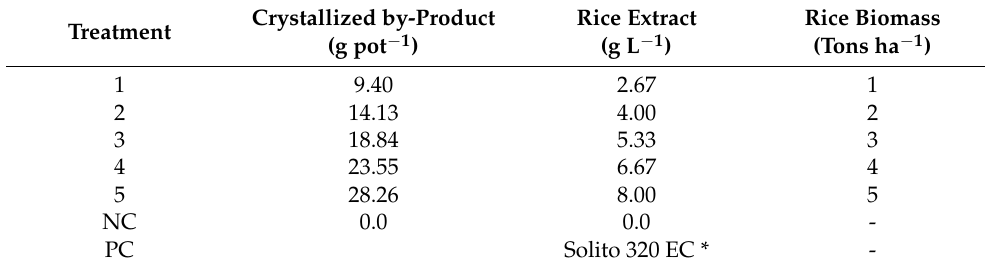
Table 1. Crystallized rice by-products and corresponding rice extract derived from mature rice biomass. By-products and rice extract used for grass weed suppression under greenhouse conditions.